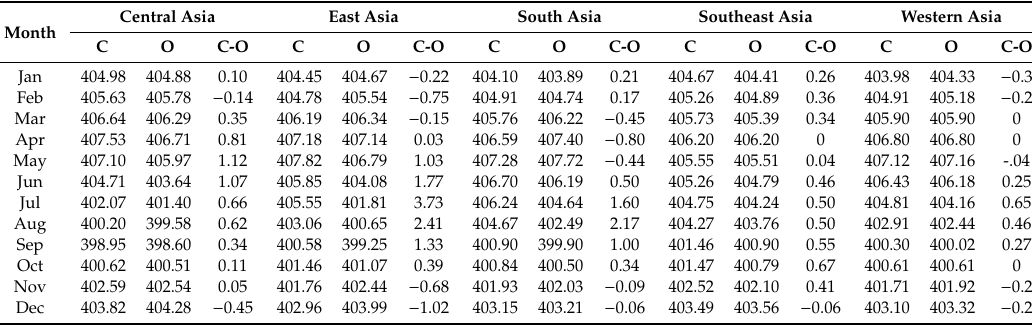
Table 5. Monthly averaged XCO 2 concentration derived from the CT (C), OCO-2 (O) and their di ff erences (C-O). The statistics are computed for 5 years over Central Asia, East Asia, South Asia, Southeast Asia, and Western Asia. (Unit: ppm). Central Asia East Asia South Asia Southeast Asia Western Month